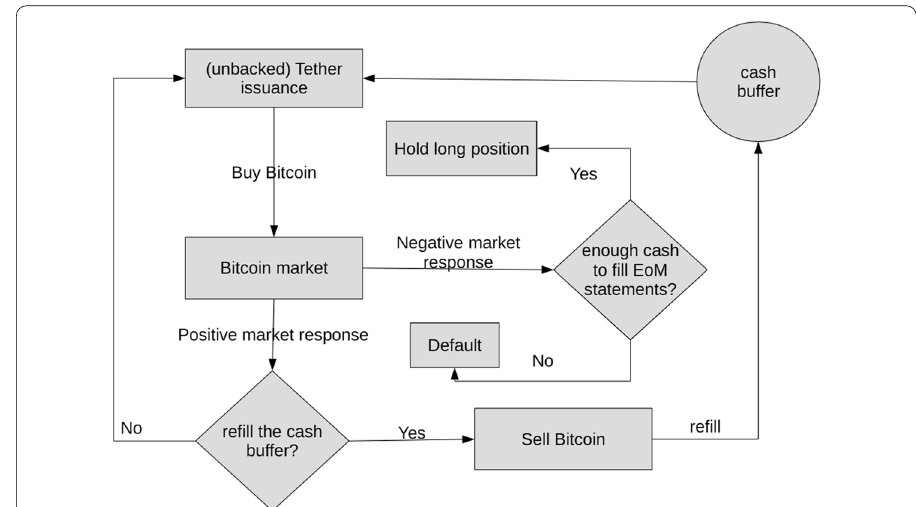
Fig. 1 Price inflation scheme. Unbacked Tether is issued and pushed into Bitcoin market. The fraudulent trader must have enough cash to cover the EoM